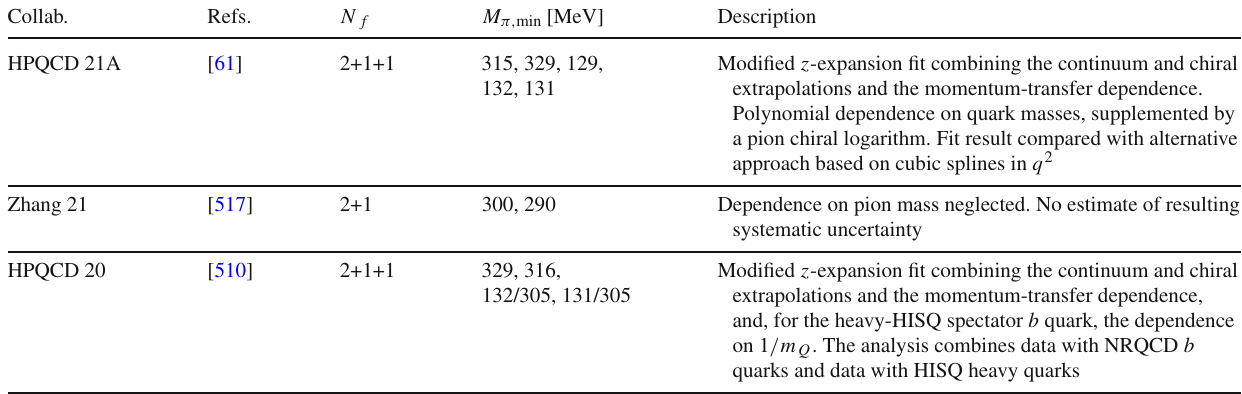
Table 136 Chiral extrapolation/minimum pion mass in determinations of form factors for semileptonic decays of charmed hadrons. For actions with multiple species of pions, masses quoted are the RMS pion masses for N f = 2 + 1 and the Goldstone mode mass for N f = 2 + 1 + 1. The different M π, min entries correspond to the different lattice spacings Collab.